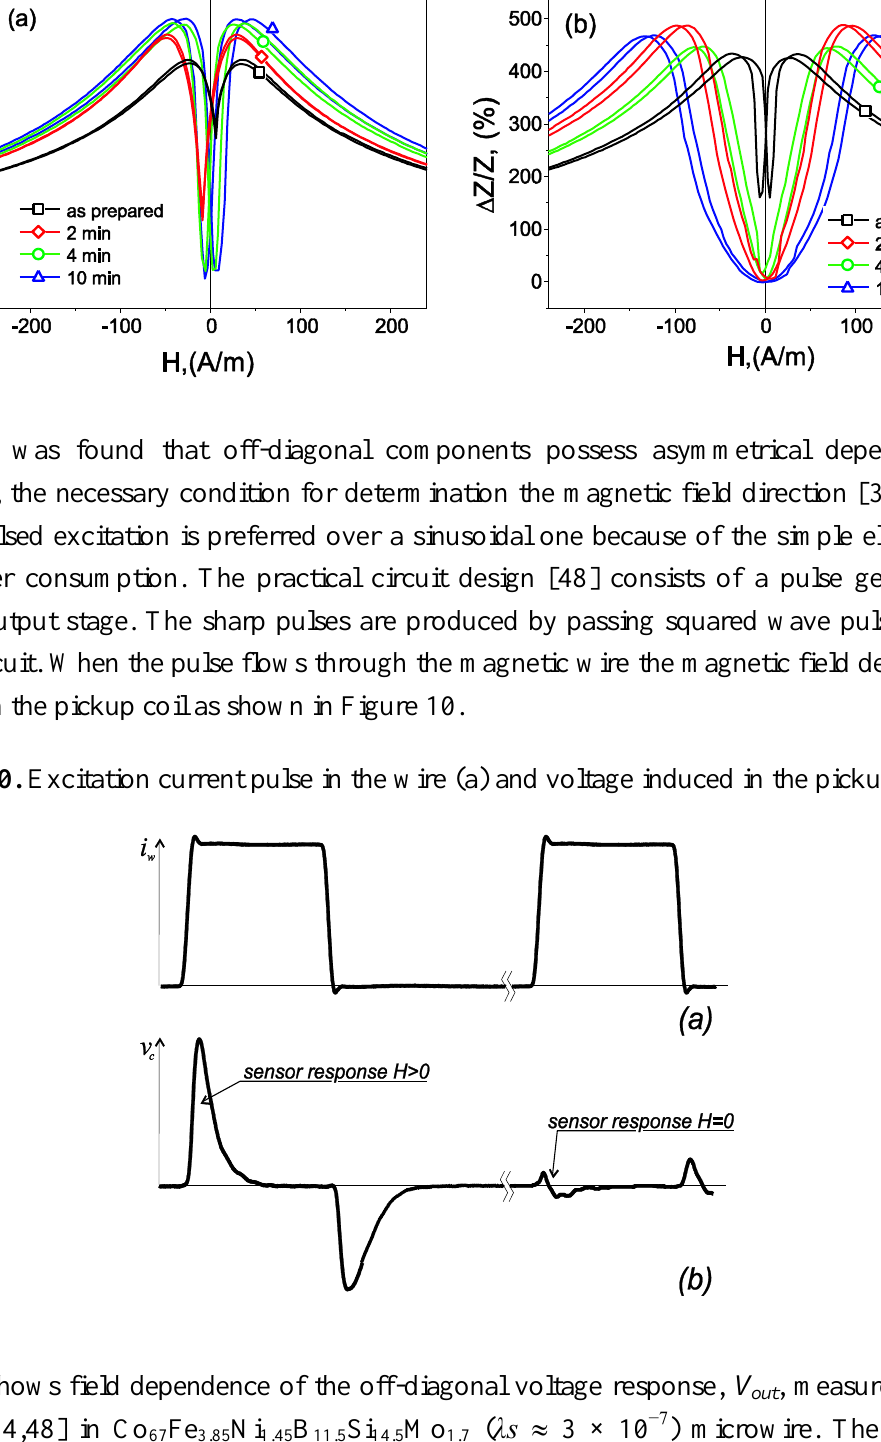
Figure 9. ΔZ/Z(H) dependences measured at (a) f = 30 MHz and I = 1 mA in annealed at 30 mA and (b) at 40 mA of Co